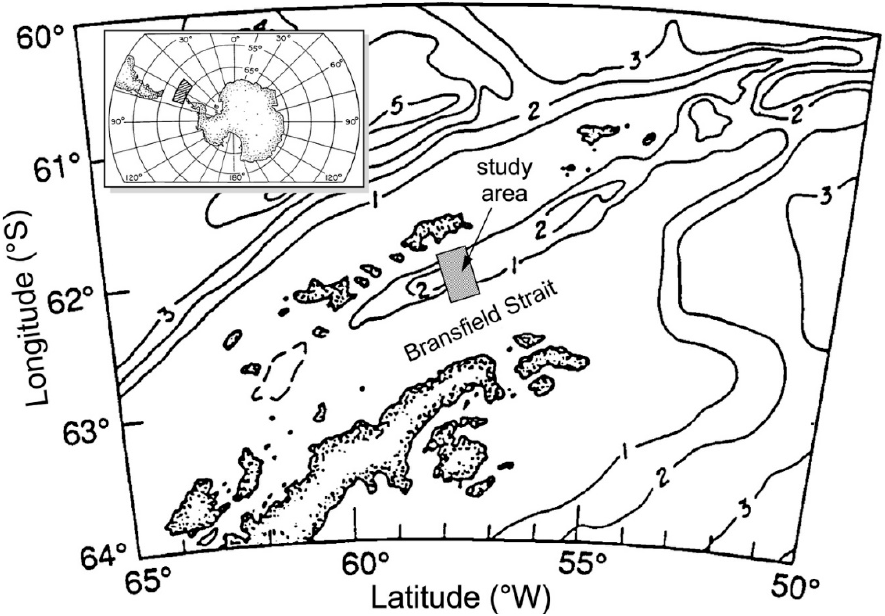
Figure 1. Location map of Bransfield Strait study area. Numbers 1, 2, 3, etc., on the map are 1000 m isobaths.